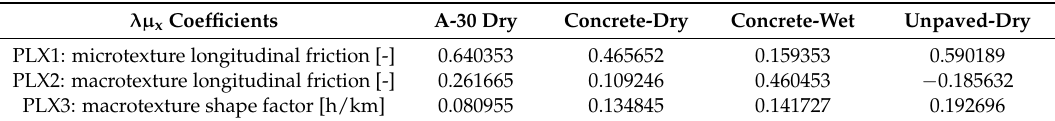
Table 4. Tire model parameters of the modified Magic Formula. Dry asphalt, dry concrete, wet concrete, and dry unpaved surface.